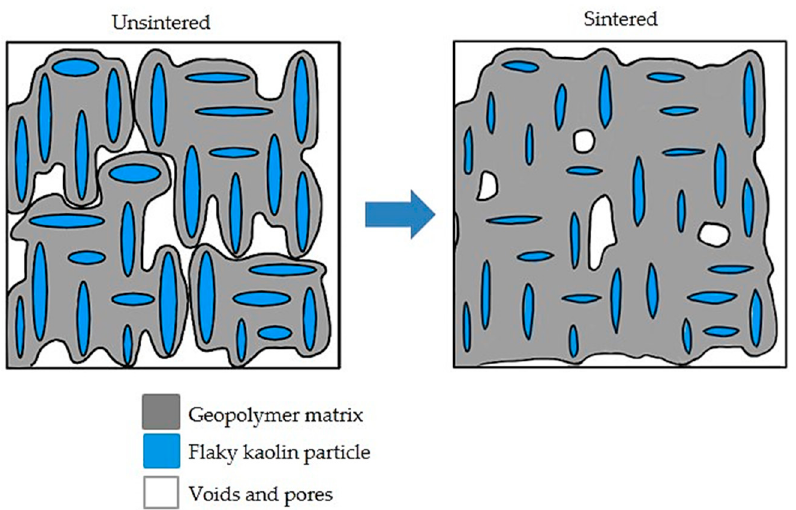
Figure 4. ( a ) Flexural strength and ( b ) relative percentage change of unsintered and geopolymer- based nepheline ceramics sintered at 900 °C and 1200 °C with different heating rates of 2 °C/min, 5 °C/min and 10 °C/min.